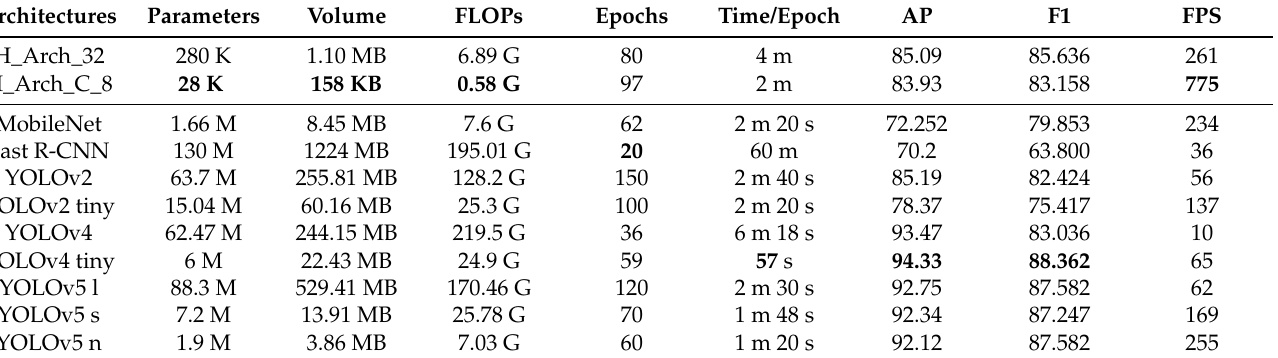
Table 10. Comparison results on HRSID.